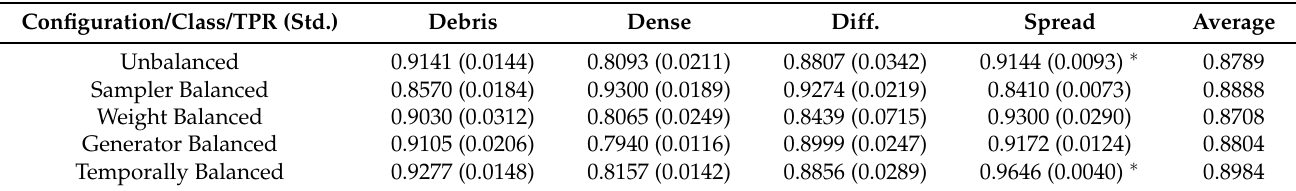
Table 8. Classwise true positive rate for four-class CNN with and without dataset balancing. Several variations of balancing are used here, the most effective of which is supplementation using generated images in line with the temporal training configuration proposed in this paper. The p -value indicated by the ∗ is calculated using Student’s t